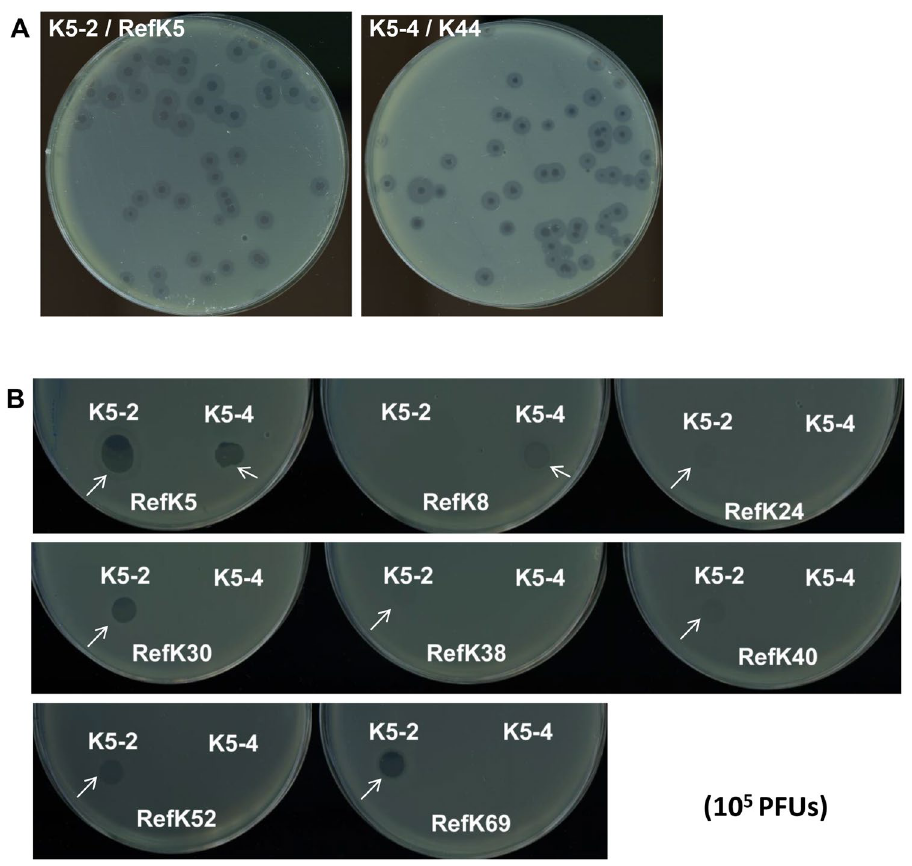
Figure 1. Plaque shape and spot tests of phages K5-2 and K5-4. ( A ) Clear plaques surrounded by translucent halos are observed on the plate with phages K5-2 and K5-4 filtrate incubated with the Klebsiella reference K5 strain and K . pneumoniae NTUH-K44 strain. ( B ) Spot tests of K5-2 and K5-4 (10 5 PFU) on 77 Klebsiella K serotype reference strains and two new type N1 and N2 strains. The reference K5 strain was used as a positive control (positive reactions are indicated by a white arrow). Negative reactions are observed in the other reference strains (data not shown).